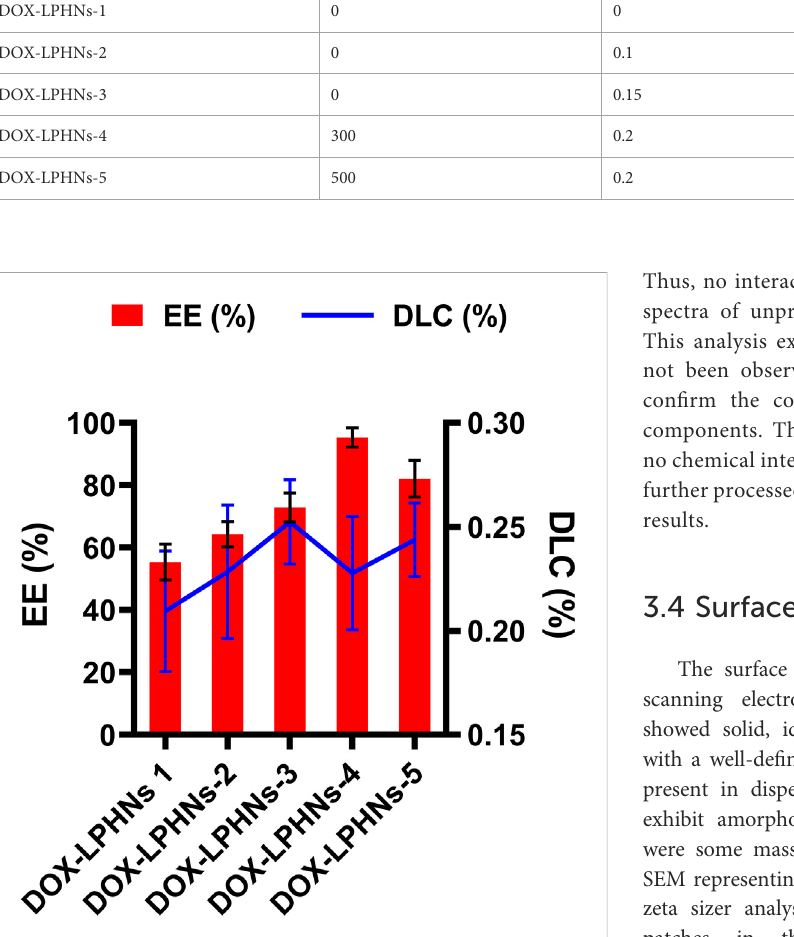
TABLE 2 EE and DLC of different DOX-LPHNs (1 – 6) formulations with different concentrations. DOX-LPHNs formulation